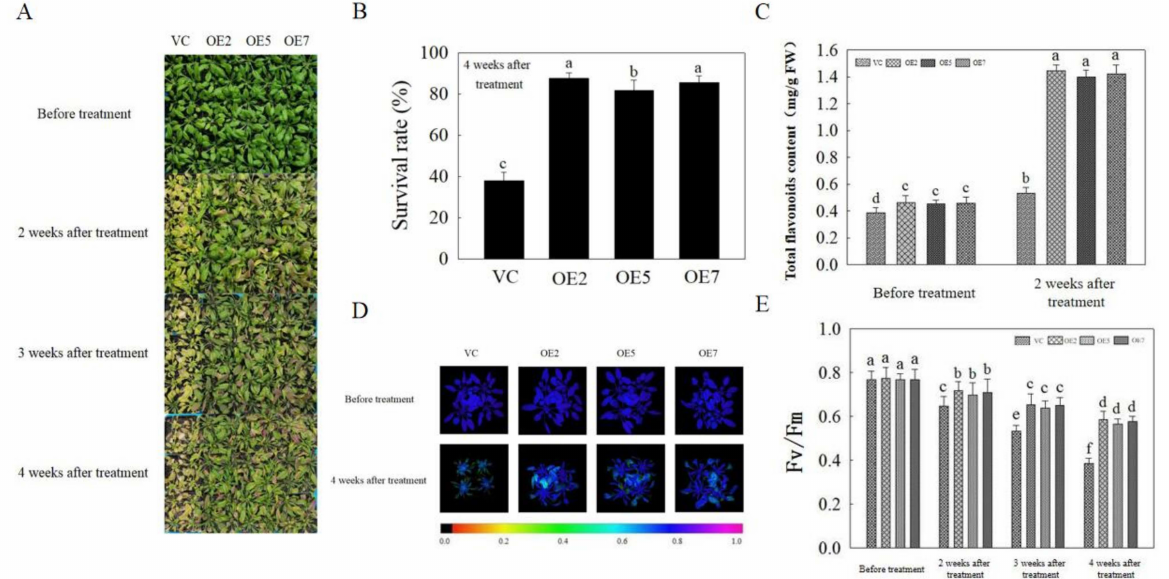
Figure 7. Phenotypic and physiological indexes of vector control (VC) and overexpression (OE) Arabidopsis under normal and stress conditions. ( A ) The phenotypic of VC and OE Arabidopsis under normal and stress conditions. ( B ) The survival rate of VC and OE Arabidopsis after salt stress. ( C ) The total flavonoid contents of VC and OE Arabidopsis under normal and stress conditions. ( D ) The Fv/Fm images of VC and OE Arabidopsis under normal and stress conditions. ( E ) The Fv/Fm value of VC and OE Arabidopsis under normal and stress conditions. Different letters represent significant difgerences ( p <